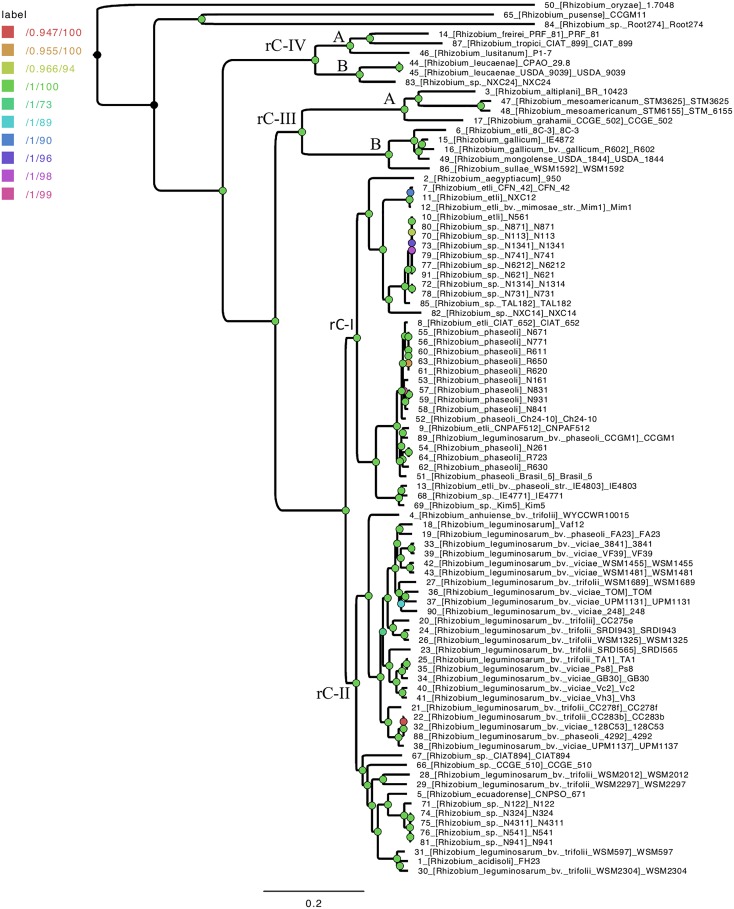
Species core genome phylogeny of 91 Rhizobium strains. Three additional Rhizobium strains were used here as outgroup for rooting: R. oryzae 1.7048, R. pusense CCGM11, and Rhizobium sp Root 274. The ML tree is based on consensus core proteins defined by the GET-HOMOLOGS package and selected for optimal phylogenetic attributes and the GET-PHYLOMARKERS tool. The nodes identified in the ribosomal tree (Supplementary Figure S1) that define the clades rC-I to rC-IV are labeled on the tree. The length and depth of the branches from the nodes indicated for clades rC-III and rC-IV, support two underlying clades (A and B) formed by highly divergent Rhizobium species.